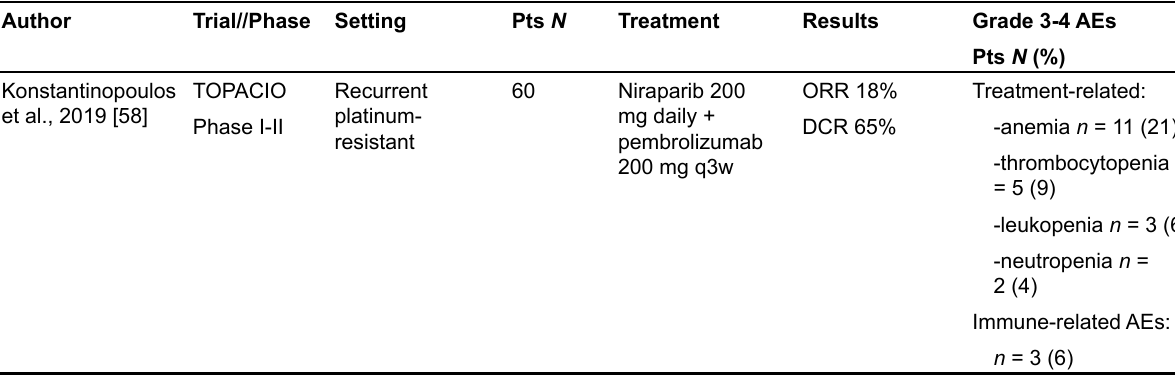
Table 3. Clinical trials in epithelial OC, EOC ( continued